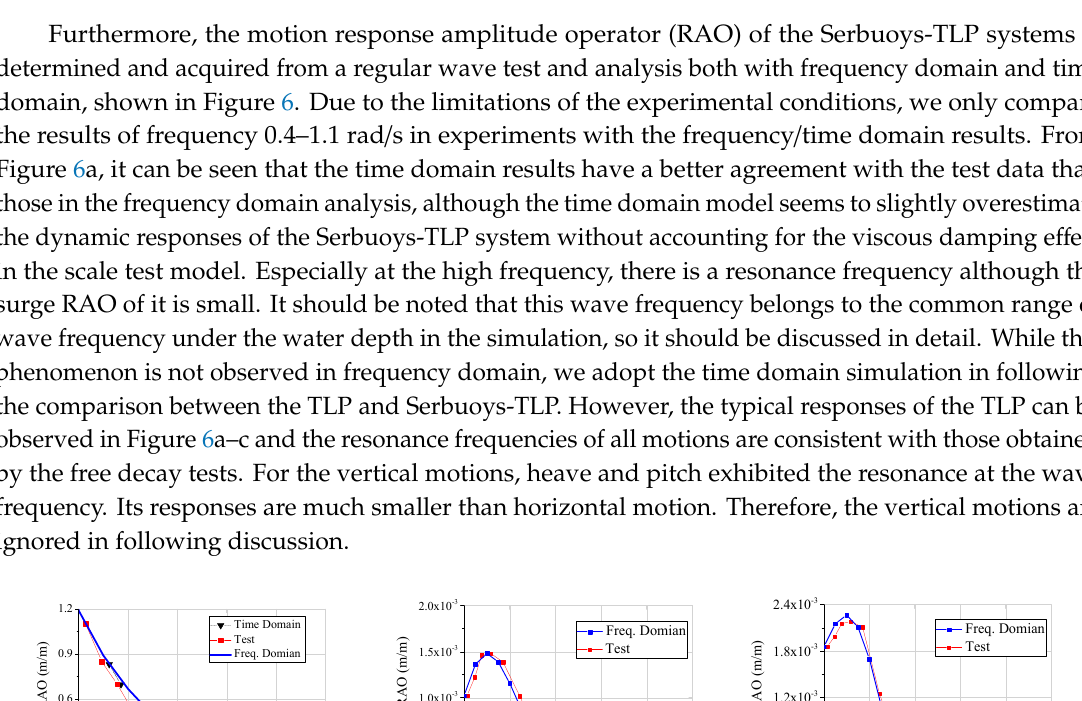
Table 3. Working condition settings.